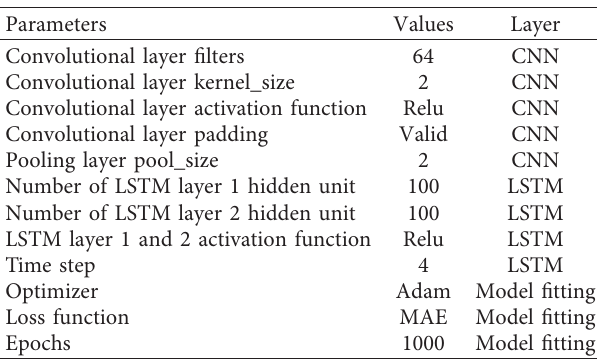
Table 2: Parameters configuration for the proposed multivariate CNN-LSTM model.